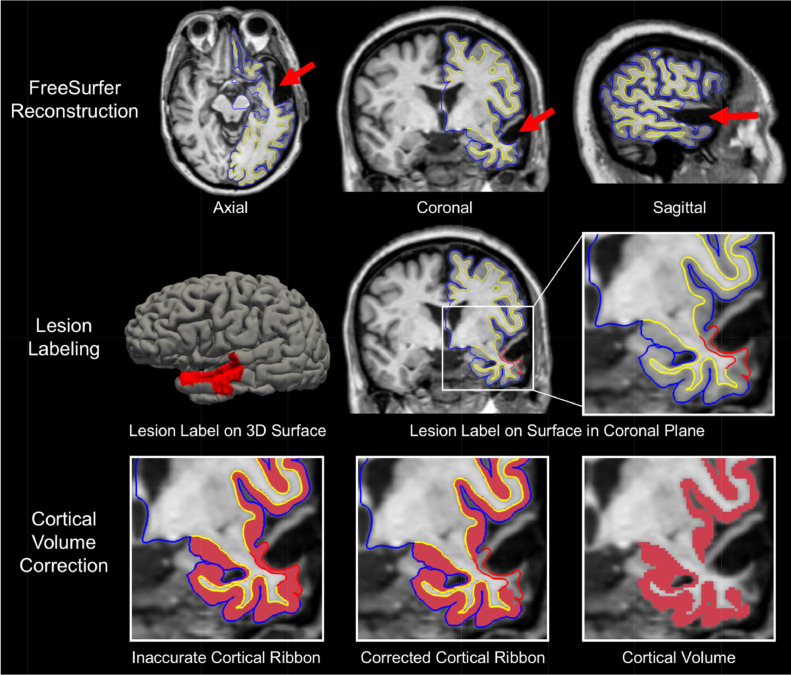
Overview of Lesion Correction Method.